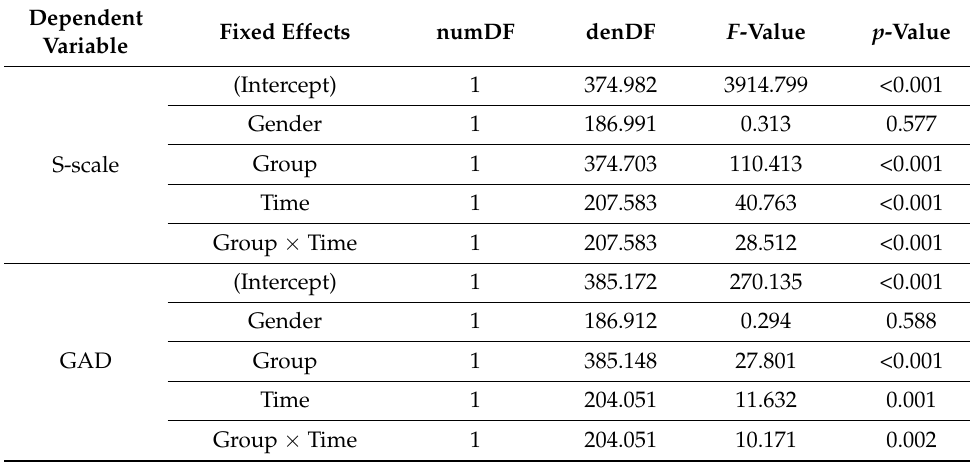
Table 3. Results of linear mixed model (gender, group, time, group ×